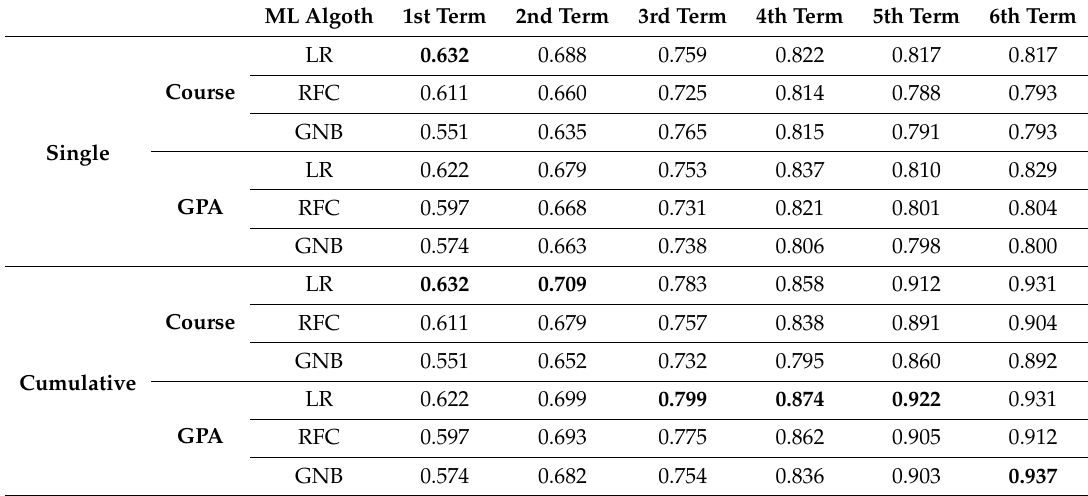
Table 8. Accuracy results of the the ML Models with the academic and pre-college features. ML Algoth 1st Term 2nd Term 3rd Term 4th Term 5th